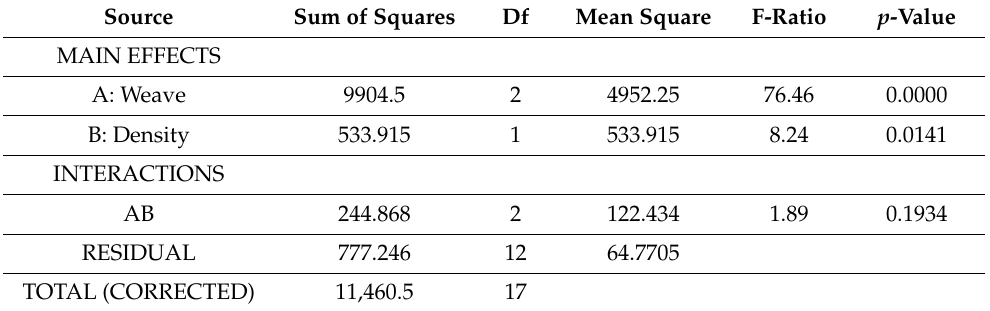
Table 8. Impact of weave and density on the adhesion force for double fabrics for z1. Source Sum of Squares